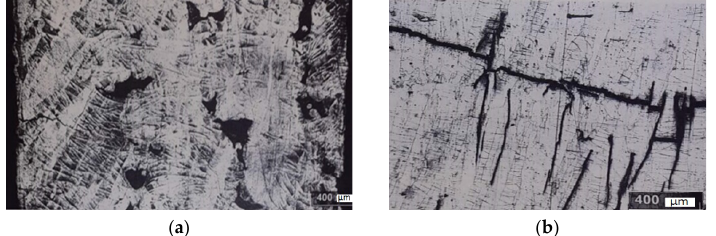
Table 2. The experimental plan.